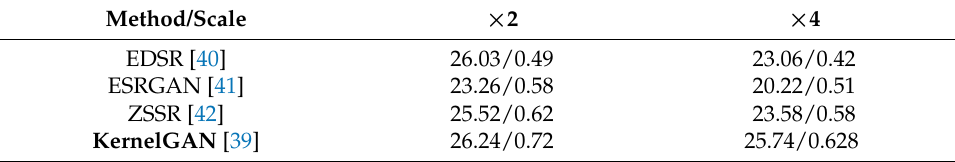
Table 1. Quantitative results for super-resolution on GMSRI. We show the performance of